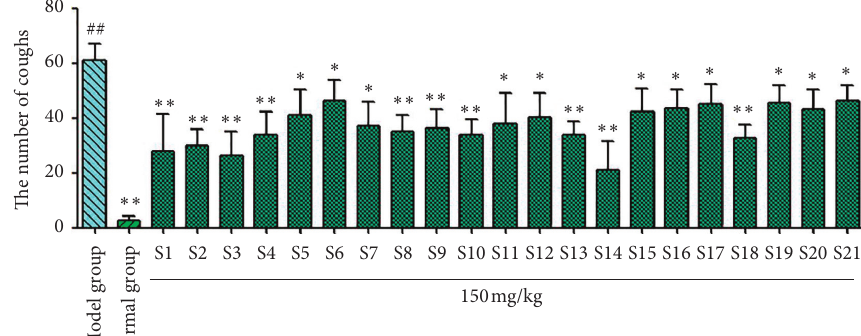
Figure 6: Results of SO 2 -induced cough in Glycyrrhiza uralensis Fisch. flavonoids from 21 producing areas. The result represents mean ± S.D. Note. Compared with the normal group, ## P < 0 . 01 is a very significant difference. Compared with the model group, ∗ P < 0 . 05 was considered to be significant; ∗ ∗ P < 0 . 01, and there was a significant difference ( n � 10).